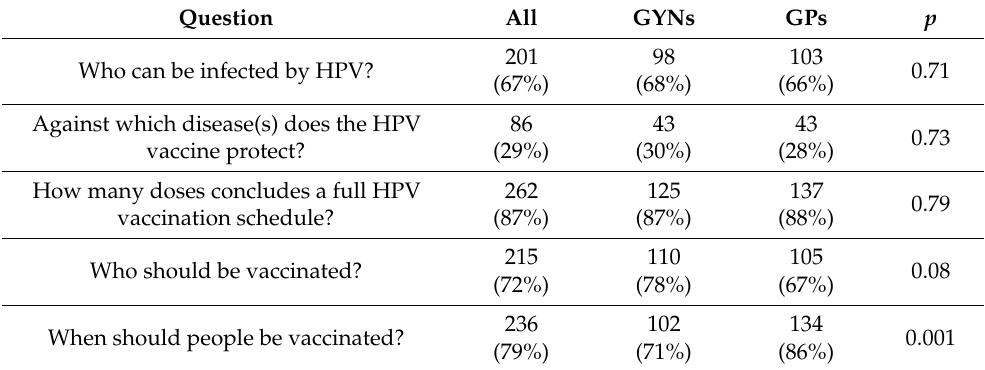
Table 8. Distribution of correct answers among examined